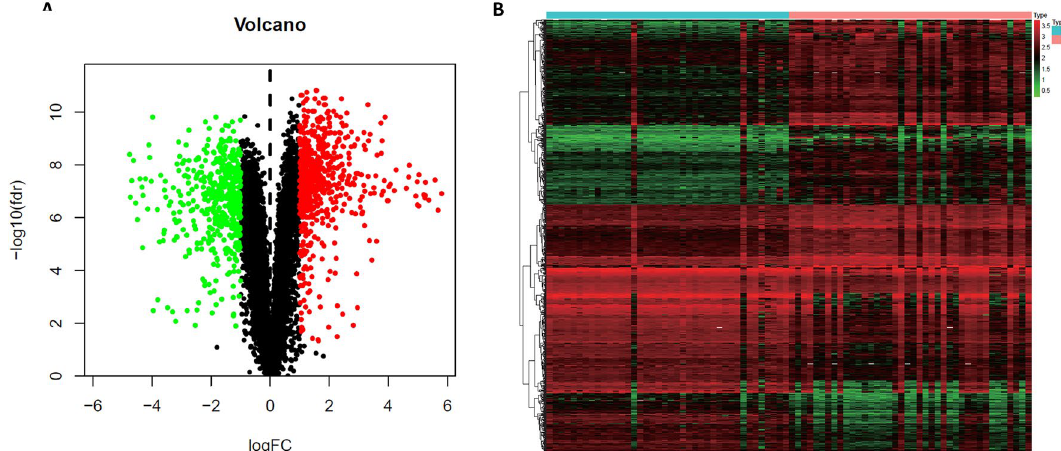
Figure 1. Identification of DEGs form GEO dataset. ( A ) The volcano plot of DEGs between BE and NE samples. ( B ) The heatmap plot of DEGs between BE and NE samples.